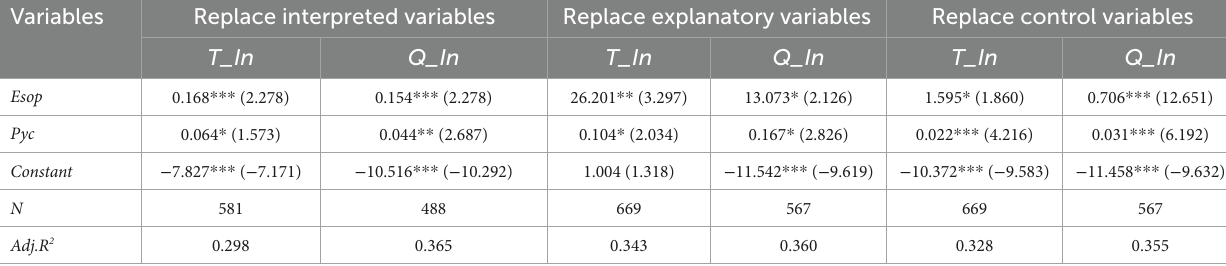
TABLE 7 Robustness test results.